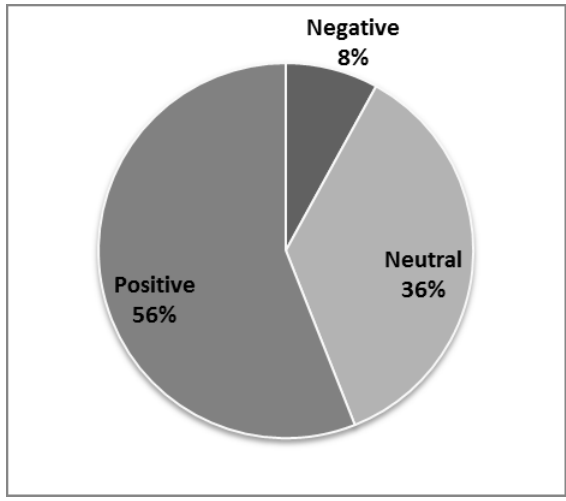
Figure 1. Distribution of classes in noisy-labeled text